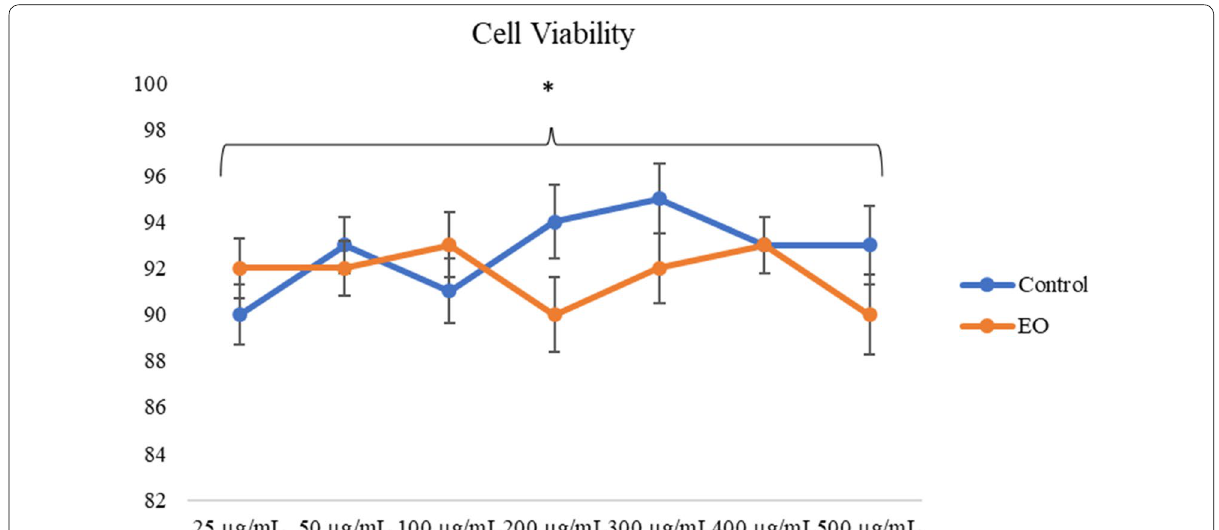
Fig. 2 Each row represents mean and standard deviation of three independent assays. Where *p < 0.05 demonstrated that there was no statistically significant difference in relation to the control group according to the unpaired Student’s t test with a 95% confidence